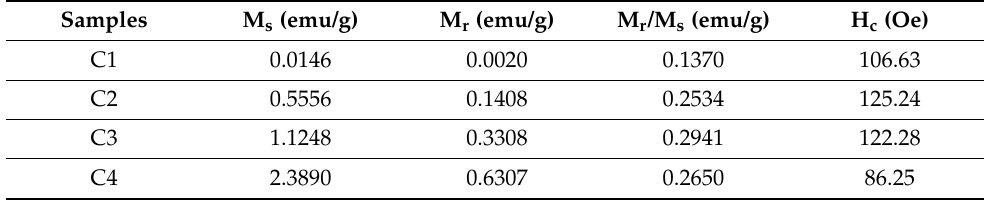
Table 6. The magnetic properties of the C1, C2, C3, and C4